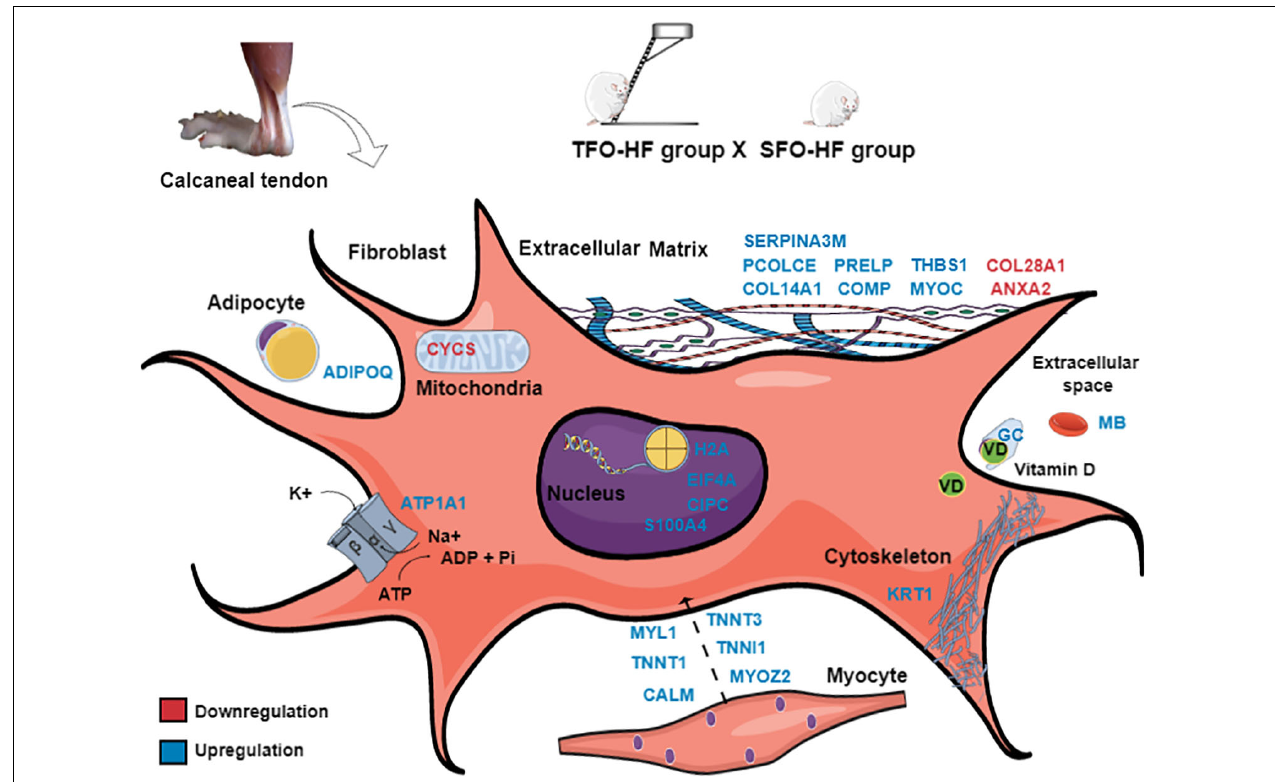
FIGURE 9 | Paternal resistance training affects offspring calcaneal tendon proteome exposed to high-fat diet. SFO-HF, offspring from sedentary fathers exposed to high-fat diet; TFO-HF, offspring from trained fathers exposed to a high-fat diet. The main upregulated (red) and downregulated (blue) proteins in the analysis (TFO-HF: SFO-HF). Adipocyte = Protein Adipoq (ADIPOQ). Cell membrane = Sodium/potassium-transporting ATPase subunit alpha-1 (ATP1A1). Cytoskeleton = Keratin, type II cytoskeletal 1 (KRT1). Extracellular space = Vitamin D-binding protein (GC), Serum albumin (MB). Extracellular matrix = Annexin A2 (ANXA2), Cartilage oligomeric matrix protein (COMP), Myocilin (MYOC), Procollagen C-endopeptidase enhancer 1 (PCOLCE), Prolargin (PRELP), Protein Col14a1 (COL14A1), Protein Col28a1 (COL28A1), Serine protease inhibitor A3M (SERPINA3M), Thrombospondin-1 (THBS1). Mitochondrion = Cytochrome c, somatic (CYCS). Myocyte = Calmodulin (CALM), Isoform 3 of Troponin T, slow skeletal muscle (TNNT3), Myosin light chain 1/3, skeletal muscle isoform (MYL1), Myozenin 2 (MYOZ2), Troponin I, slow skeletal muscle (TNNI1), Troponin T, fast skeletal muscle (TNNT1). Nucleus = Eukaryotic translation initiation factor 4H (EIF4A), Histone H2A (H2A), Protein Cipc (CIPC), Protein S100-A4